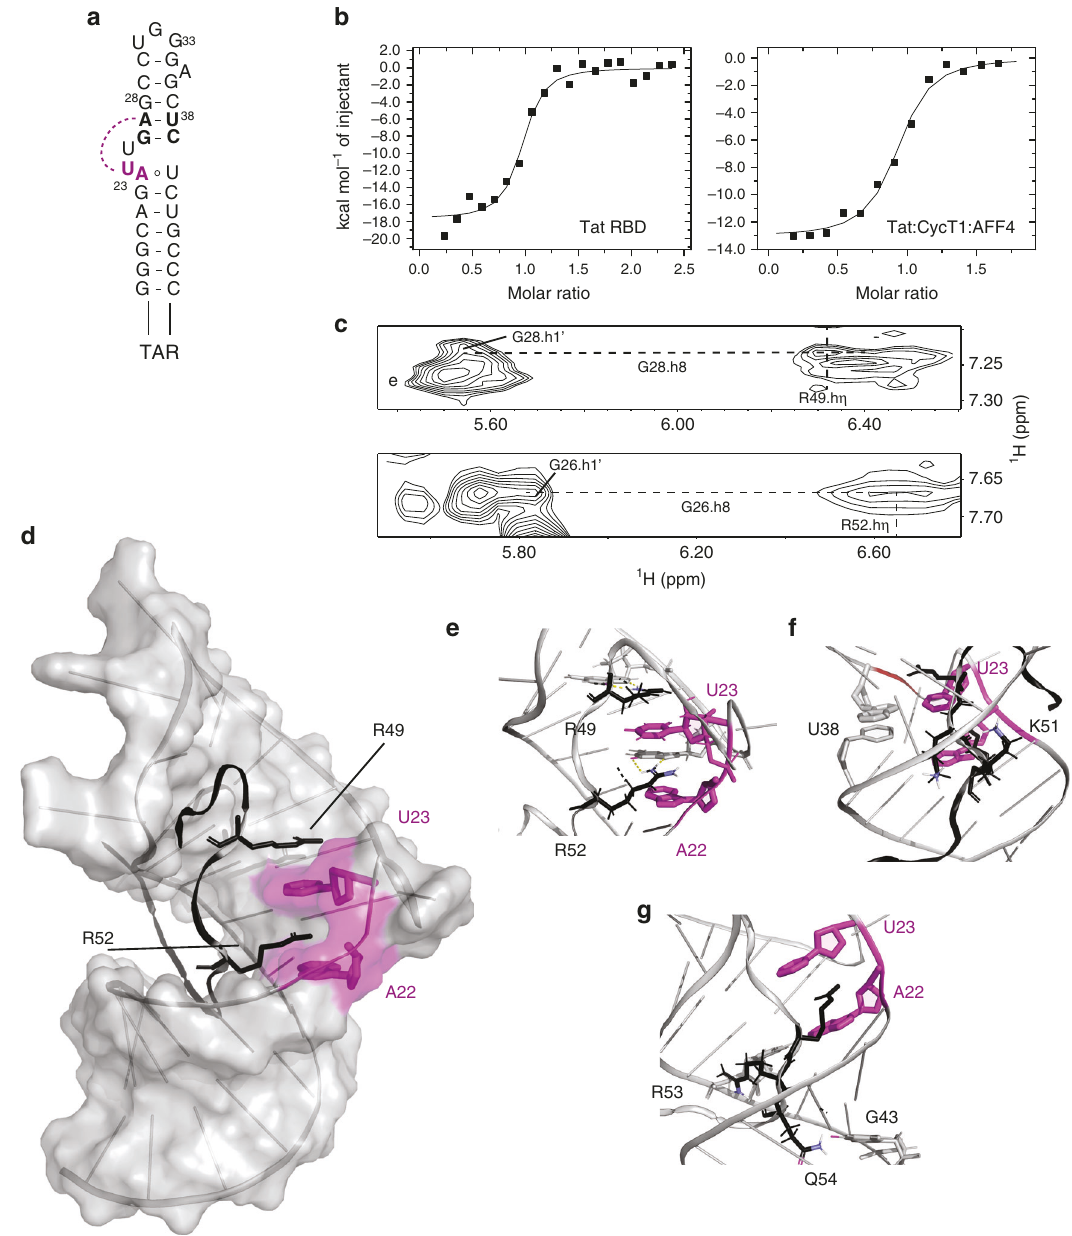
Fig. 5 Structure and characterization Tat RBD in complex with TAR. a Secondary structure of TAR where the dashed arcs represent the triple-base interactions between U 23 from the bulge to the A 27 -U 38 base pair in the stem, giving rise to the roof of the sandwich. b Representative ITC data of Tat RBD (left) and the Tat:CycT1:AFF4 (right) titration into TAR RNA, respectively. Continuous lines represent the fi t for a one-site binding model. c 1 H – 1 H two- dimensional NOESY showing the NOEs between the R49 and R52 h η guanidinium protons and G 28 and G 26 H8 protons, respectively, placing these residues in an arginine fork interaction. d NMR structure of TAR bound to Tat RBD (black) showing R49 and R52 sandwiching the U 23 cap of the ASM sandwich. e The ASM binding pocket with the A 22 base and the U 23 cap (magenta), G 26 and G 28 (gray), and R49 and R52 (black). The dotted lines indicate hydrogen bond interactions from the NH group of arginine 49 and 52 to the O6 and N7 of G 28 and G 26 , respectively. f Positions of K50 and K51 (black) in the major groove. g The R53 and Q54 interaction with U40 and G43, respectively. Close proximity of the R53 δ to the C 39 , U 40 , and C 41 H5 protons evidenced by the data and a dotted line represents the potential hydrogen bonding interaction between a guanidinium proton of R53 to the U 40 phosphate. The hydrogen bond interaction between the Q54 h ε proton and the G 43 O6 represents the C-terminal exit of Tat RBD from